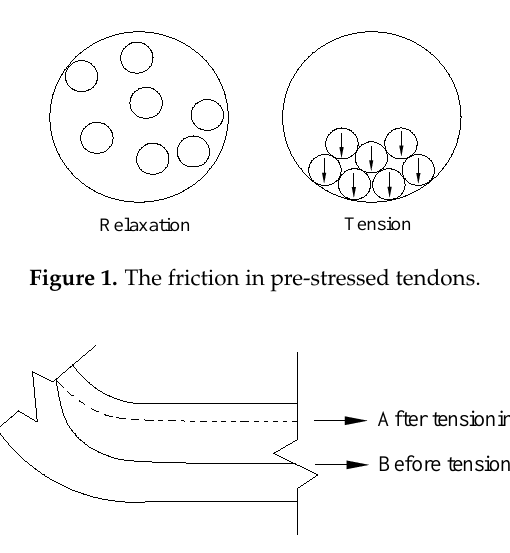
Before tensioning